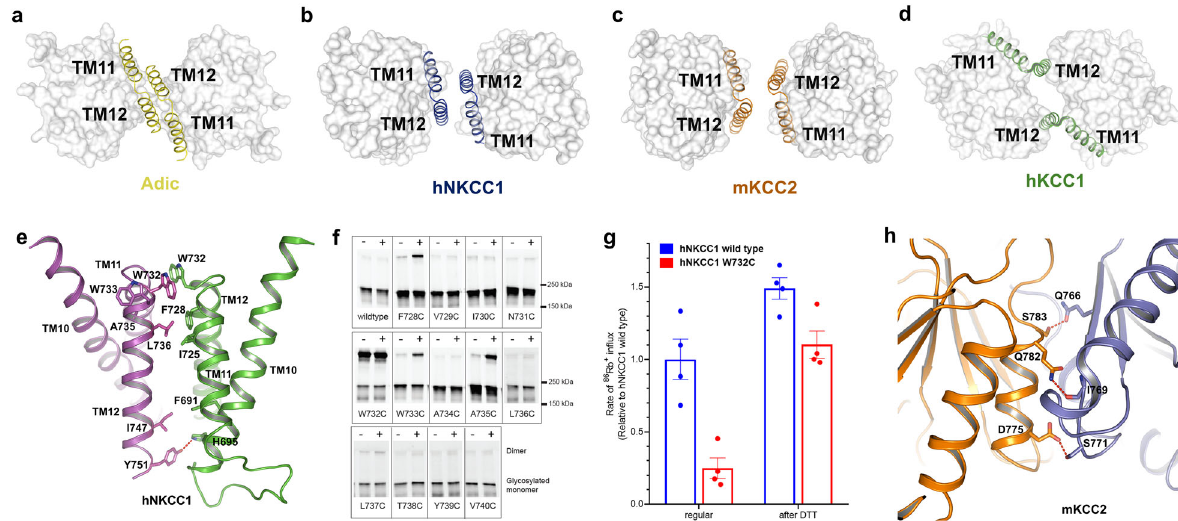
Fig. 6 Dimeric interface of hNKCC1 and mKCC2. a – d Schematic representation of the TMD dimer architecture between different transporters (Adic (yellow), hNKCC1 (blue), mKCC2 (brown), and hKCC1 (green)) with TM11-12 shown as ribbons and other TMD regions shown as surface representation. e The NKCC1 homodimer is stabilized by hydrogen bond interaction between Y751 in TM12 of one monomer with H695 in TM10 of the other; in addition, there are stabilizing hydrophobic interactions between TM11-12 hairpins (labeled residues). f Homodimeric oxidative crosslinking of NKCC1 with single cysteine substitutions in TM 11-12. Cells were treated with ( + ) or without ( − ) cupric phenanthroline before lysis. g The W732C mutant exhibits about 25% of the Rb + in fl ux activity of wild-type NKCC1. Transport activity is largely restored in W732C after a 30 min pretreatment with 40 mM DTT to break the disul fi de linkage between hNKCC1 monomers; mean ± SEM. h Cytoplasmic-domain dimeric interactions in mKCC2. D775, Q782, and S783 from one subunit (brown) form hydrogen bonds with Q766, I769, and S771 from the neighboring subunit (blue) to stabilize the